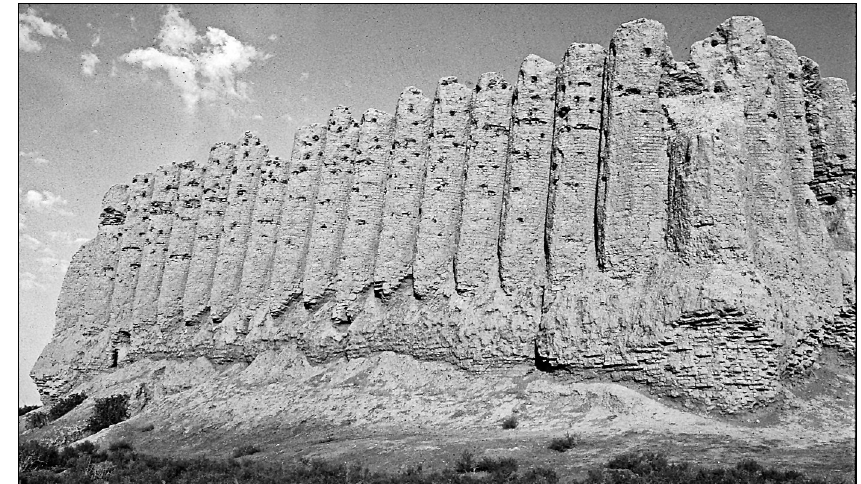
Figure 2 A view of the medieval Great Kyz Kala at Merv. This is the most impressive of the surviving köshks (defended houses) at the site, the massive corrugated mudbrick walls of which stand 12m high upon 4m-high platforms, making them the most striking and unusual buildings to have survived at ancient Merv. Note the eroding foundations of the walls.